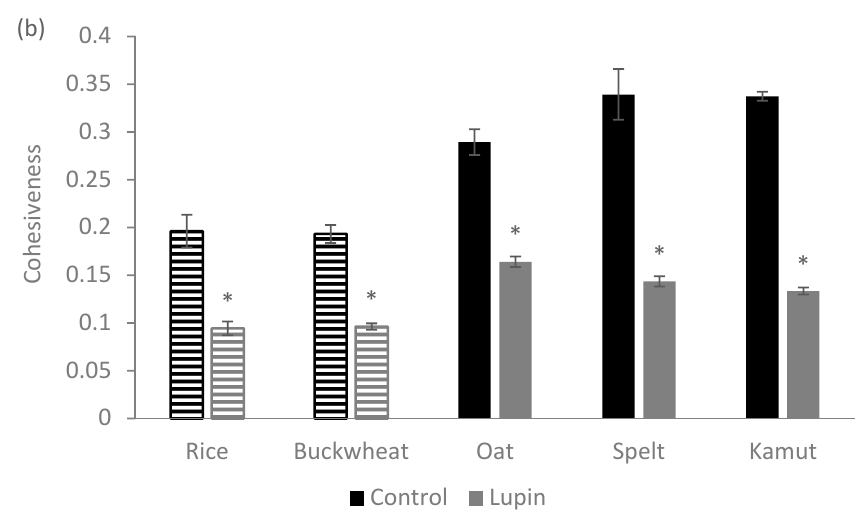
Figure 1. Texture parameters of control and lupin-enriched cookies prepared from five different flours. Solid bars represent the gluten-containing flours (oat, spelt and kamut) and the striped bars represent the gluten-free flours (rice and buckwheat): ( a ) the firmness; and ( b ) the cohesiveness. * represents p < 0.05 when compared with the corresponding control cookie.